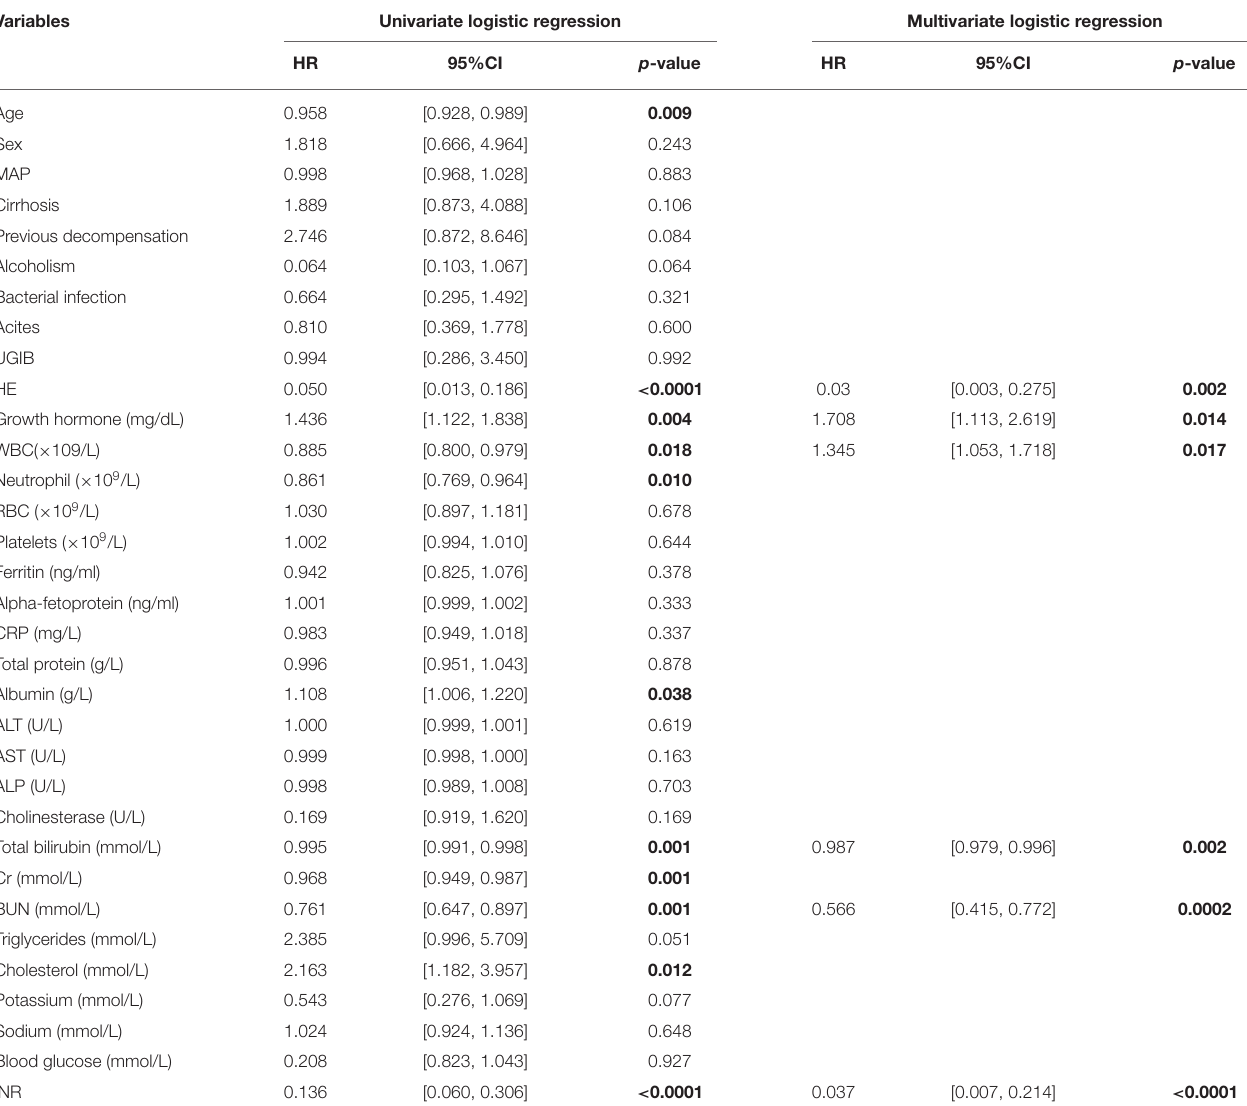
TABLE 3 | Univariate and multivariate logistic regression analyses of 30-day survival in the study cohort. Variables Univariate logistic regression Multivariate logistic